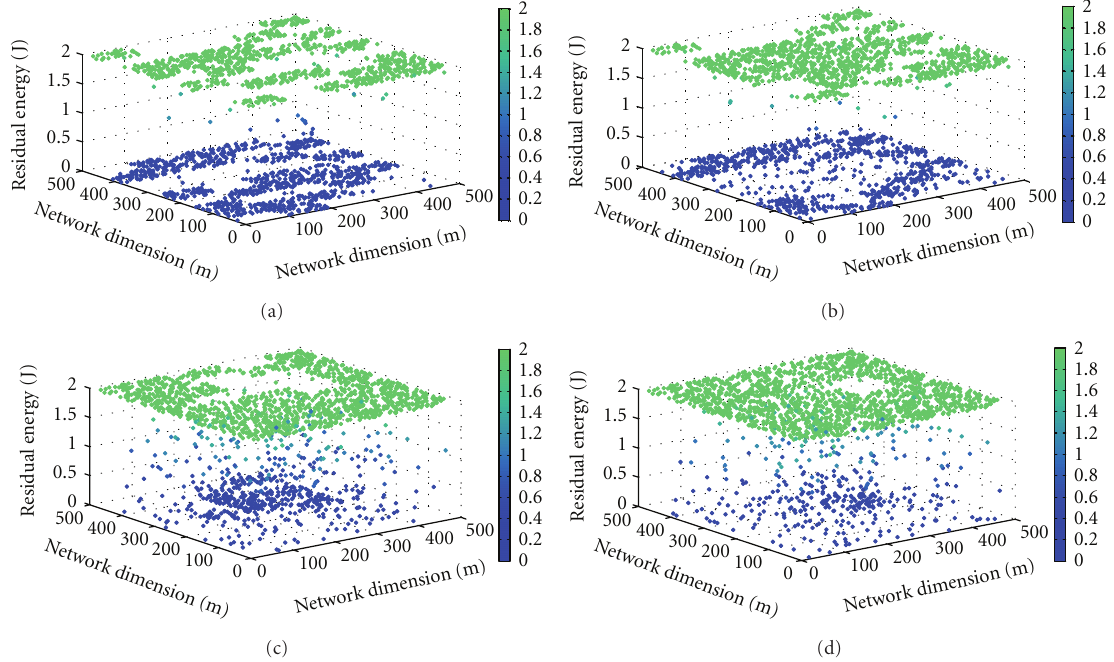
Figure 18: The obtained results after receiving 5000 frames at the base station with QCIF Akiyo video in case of having channel error: (a) MPEG-2/H.262 scheme, (b) Magli scheme [20], (c) the proposed scheme 1, and (d) the proposed scheme